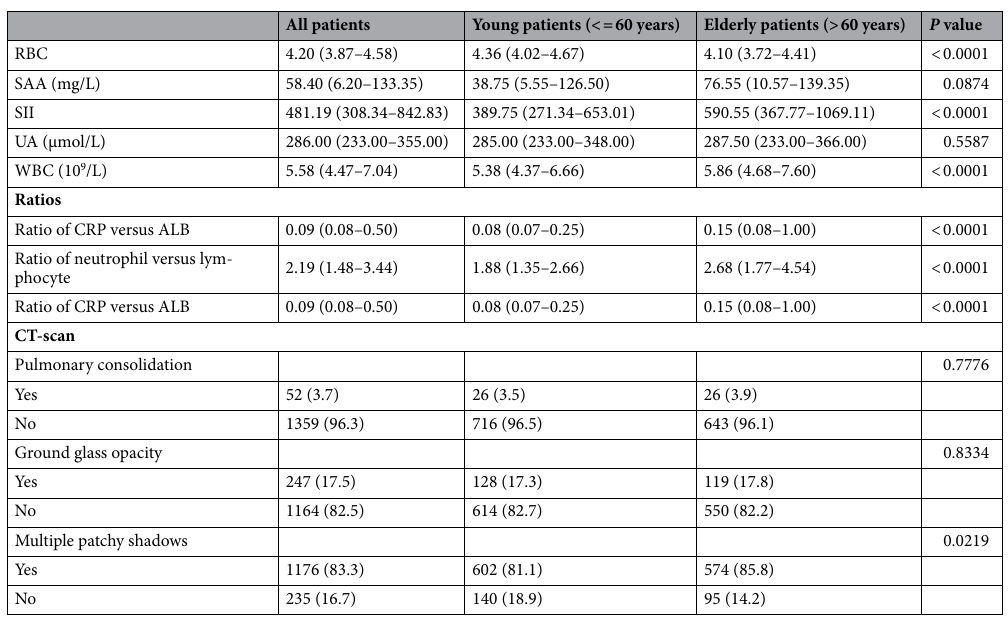
Table 1. Clinical and demographic characteristics, treatment and key laboratory findings. Metric covariates are reported as medians with interquartile ranges in the following form: ’Median (First Quartile-Third Quartile)’. Categorical covariates are reported as percentages in the following form: ’Absolute number (Percentage)’. Differences between the young and elderly patients were tested using the Wilcoxon test and Fisher’s exact test for metric covariates and categorical covariates, respectively. The following abbreviations are used in the table: ALB: albumin, ALT: alanine aminotransferase, ANC: absolute neutrophil count, AST: aspartate aminotransferase, BUN: blood urea nitrogen, CK: creatine kinase, CK-MB: creatine kinase-MB, Cr: creatinine, CRP: C-reactive protein, LDH: lactate dehydrogenase, LYM: lymphocyte, MONO: monocyte, PLR: platelet-lymphocyte ratio, RBC: red blood cell, SAA: serum amyloid alpha, SII: systemic immune- inflammation index, UA: uric acid, WBC: white blood